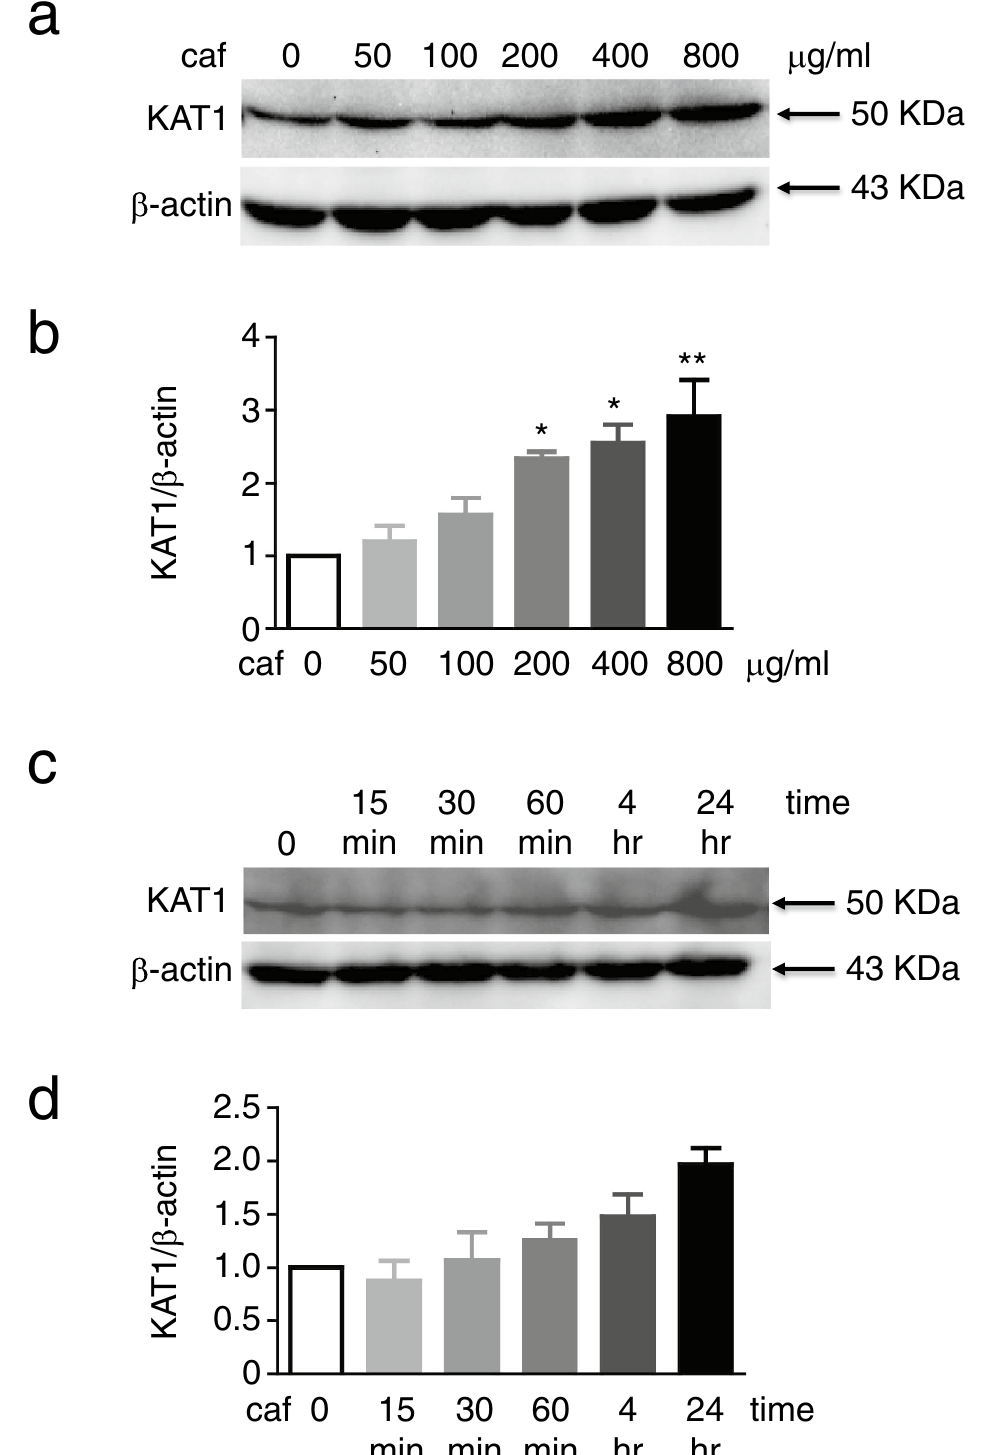
Figure 4. Caffeine induction of both KATs and PGC-1α in myotubes. C2C12 myotubes were incubated with various doses ( a ) or 400 μg/mL ( c , d ) of caffeine, for various durations ( c ) or 24 h ( a , b ), and cell lysates were prepared for western blotting analysis of KAT1 and β-actin ( a , c ). KAT1 images were normalised to the transcript level of the individual β-actin, and the relative ratio to that of the control (0 min) was calculated ( b , d ). Data are shown as mean ± SEM of the triplicate experiments. Similar results were obtained in three independent experiments. * p < 0.05; ** p <